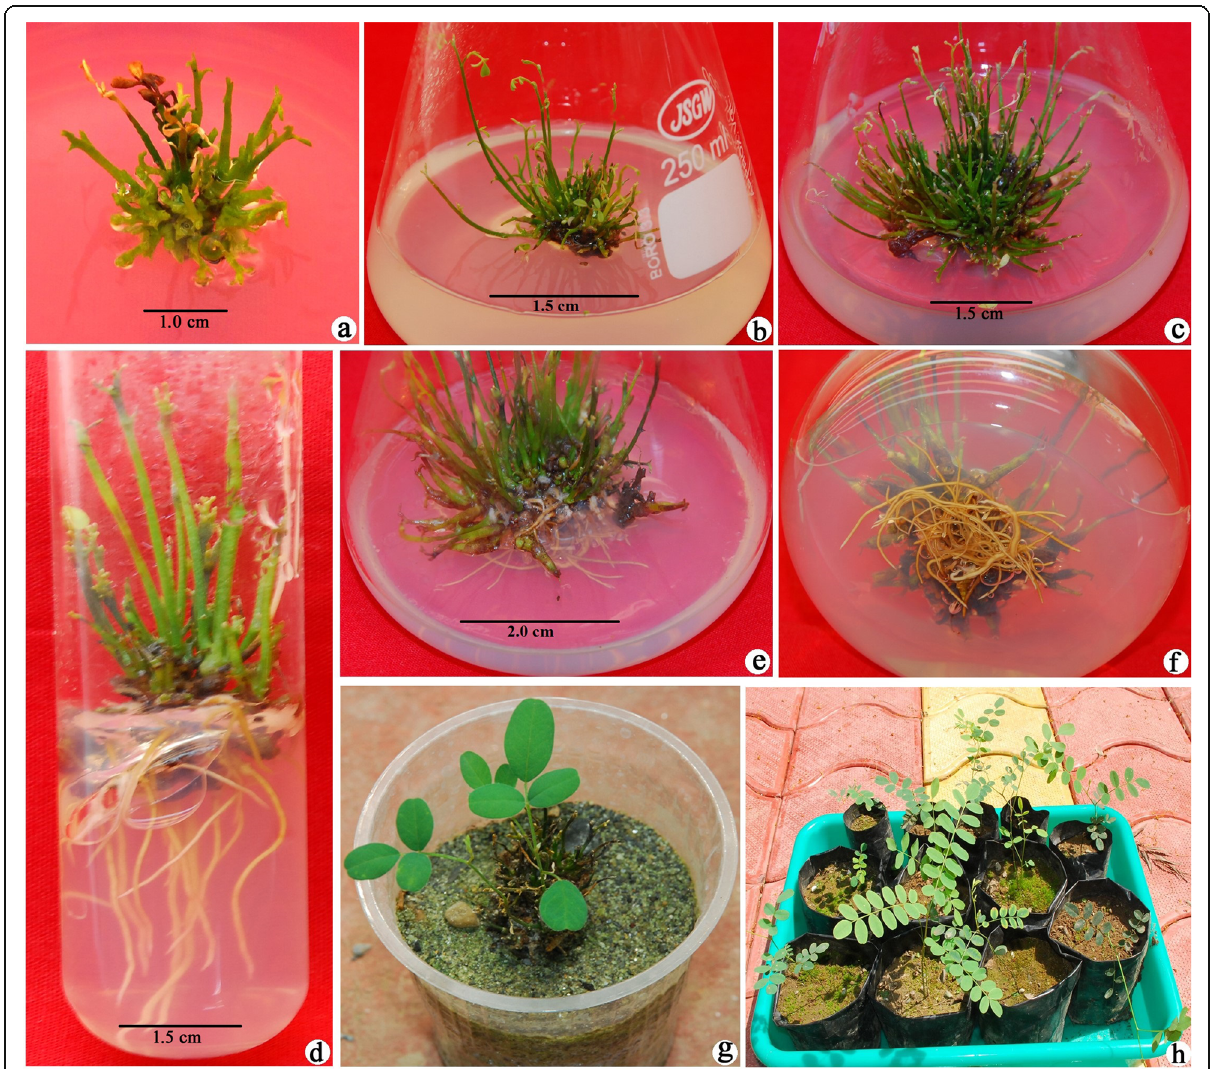
Fig. 1 Micropropagation of Sophora mollis . a Initiation of shoots from shoot tip explants inoculated onto MS medium enriched with BAP (8.9 μ M L − 1 ) after 14 days of incubation, ( b and c ) proliferation of shoots in shoot proliferation medium, ( d , e, and f ) root induction in half-strength MS medium augmented with NAA (21.20 μ M L − 1 ) after 6 weeks of incubation, ( g ) properly rooted plantlets transferred to plastic cups containing sand, ( h ) fully acclimatized plants transferred to poly bags containing soil after 4 months of